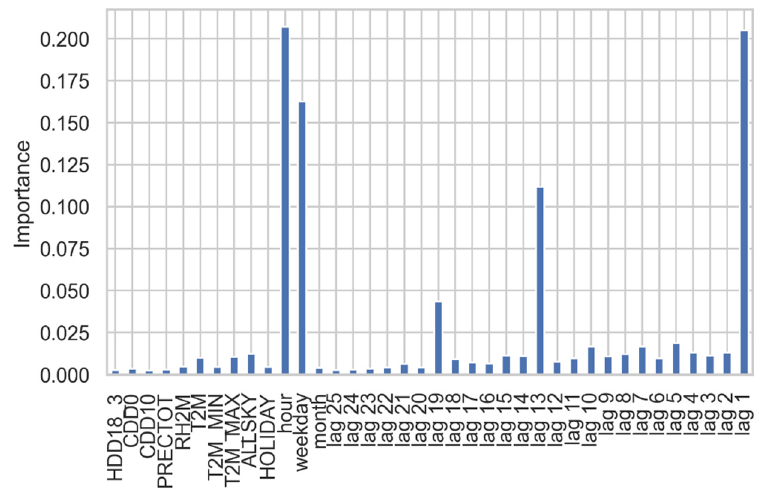
Figure 5. Random forest feature importance.